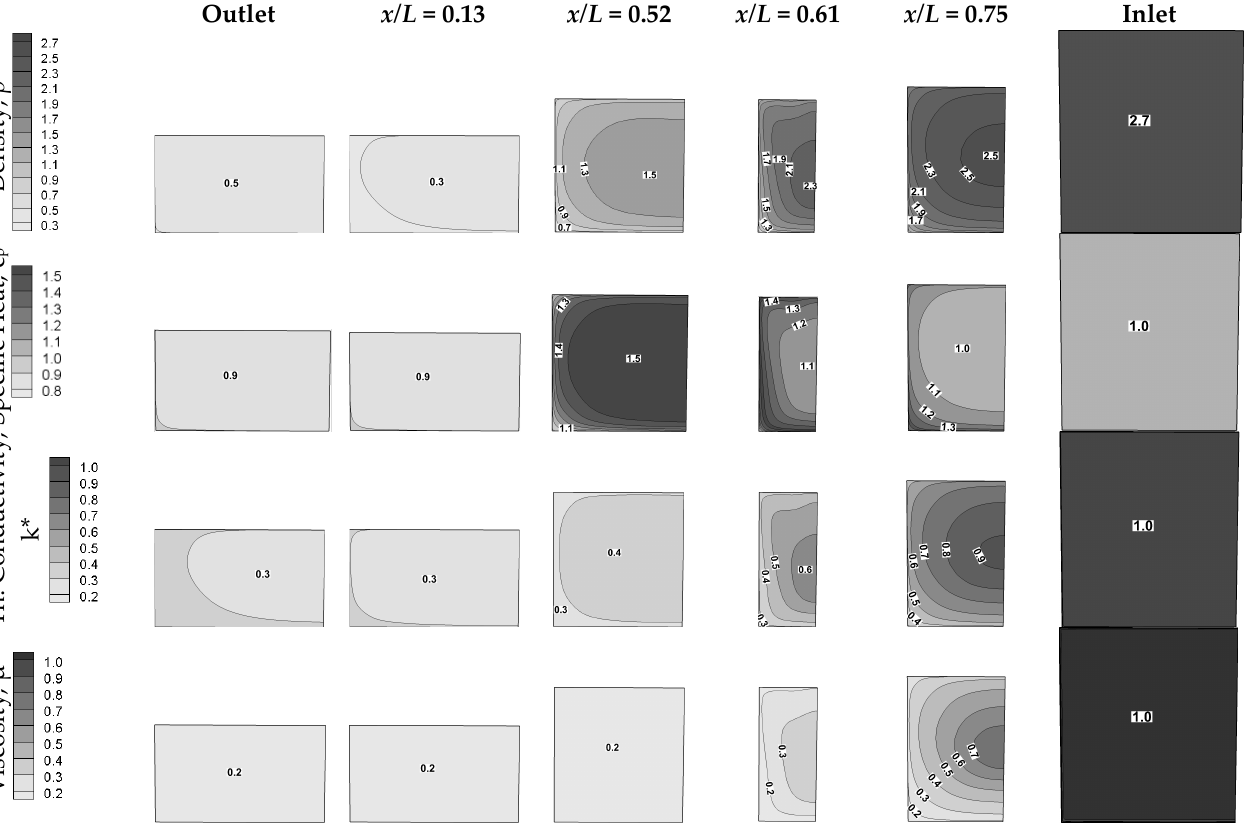
Figure 17. Nominal operating point: dimensionless fields of density, specific heat, thermal conductivity and viscosity at significant transversal slices—fluid zones. ity and viscosity at significant transversal slices—fluid